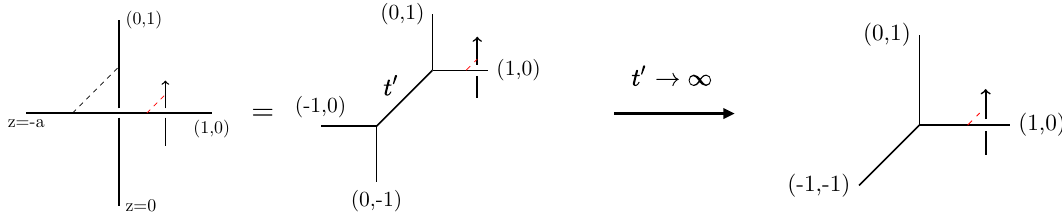
Figure 16 . The toric diagrams show the result of the geometric transition applied to the deformed reosolved with probe branes displaced from S 3 . Under the transition the S 3 is replaced by a sphere of size t 0 . On the right, we show the t 0 limit in which that sphere t 0 is sent to infinity. This results in “half” the resolved conifold geometry with probe branes inserted, which defines the Hartle-Hawking state. It is important to note that we have specified the framing for the probe D-brane for the HH state, which is determined by the direction of the arrow